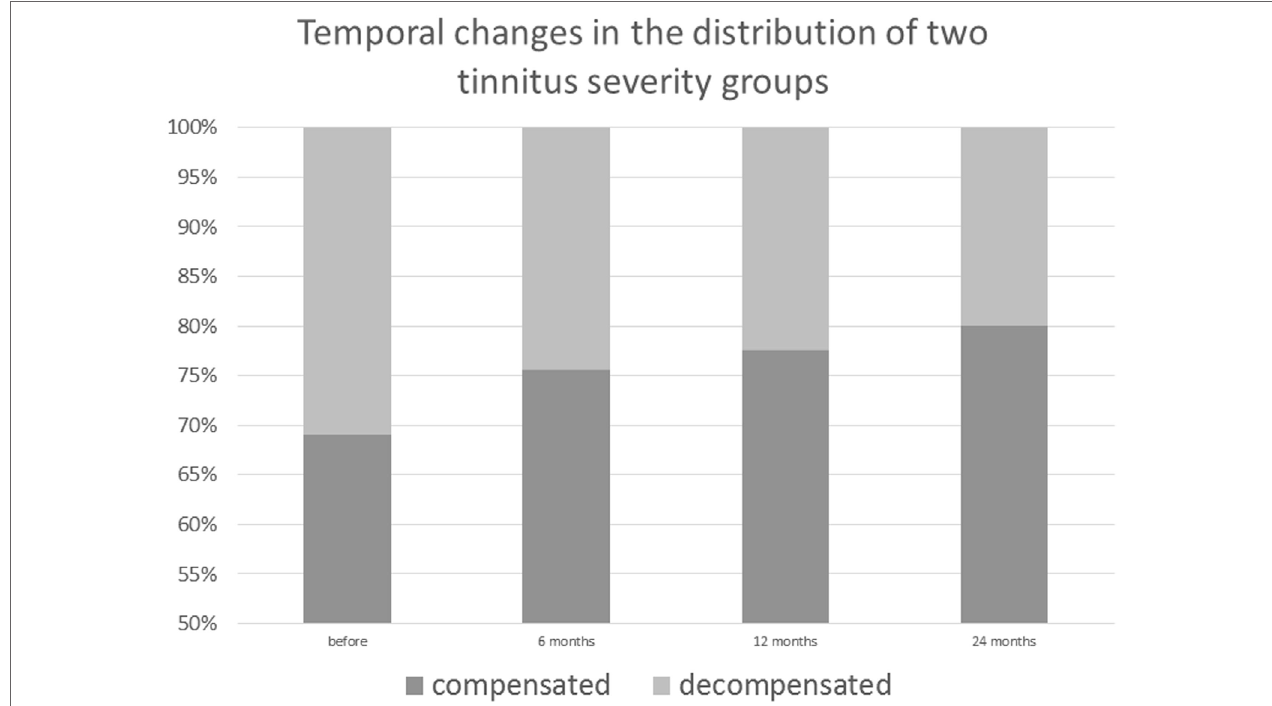
FigUre 3 | Post-cochlear implantation decrease in decompensated, severe form of tinnitus among implanted patients